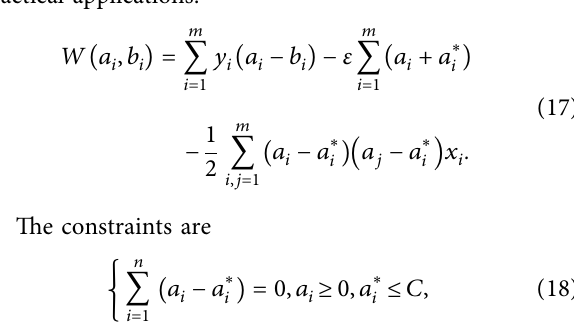
Figure 2: Original power